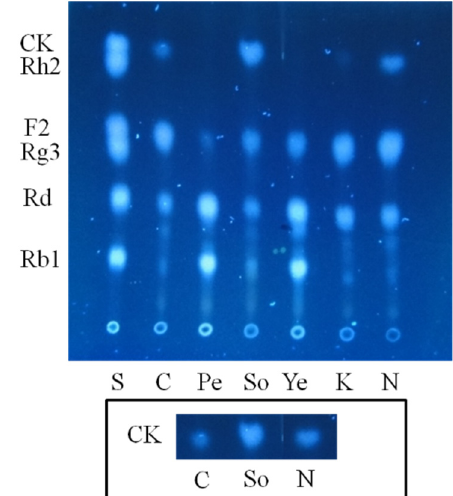
Figure 4. Influences of different nitrogen sources on the biotransformation of Rb1. C: control; Pe: peptone; So: Soybean powder; Ye: yeast; K: KNO 3 ; N: (NH 4 ) 2 SO 4 . The inlay